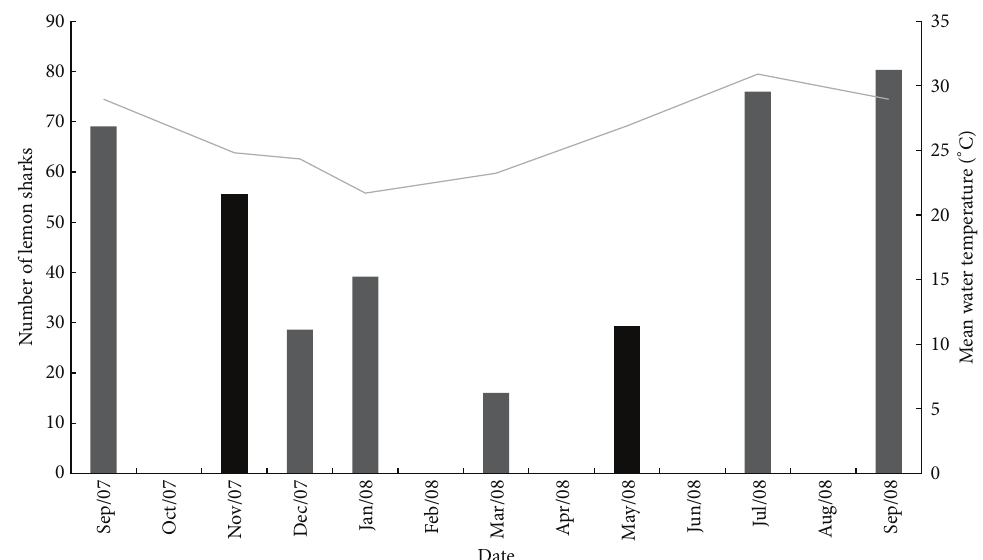
Figure 3: Lemon shark total abundance (number of lemon sharks) estimates by date, derived from aerial survey counts. Line graph represents mean monthly water temperature ( ∘ C); grey bars represent surveys conducted at low tide, and black bars represent surveys conducted at high tide.